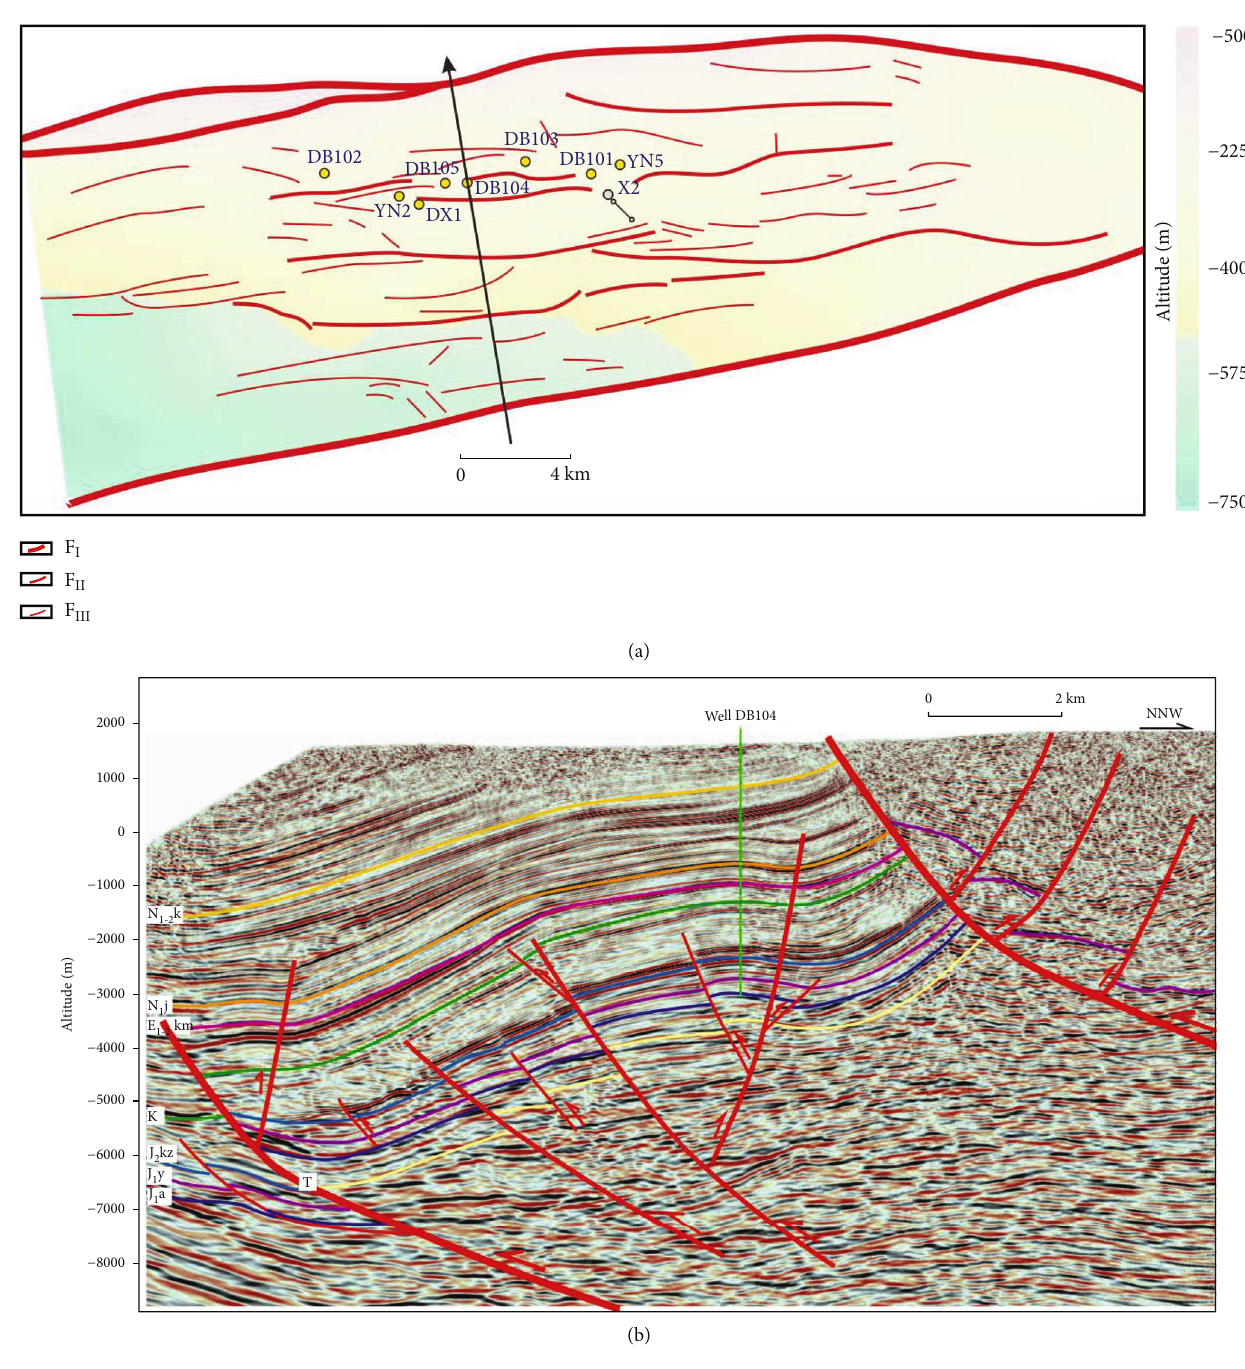
Figure 2: Top structural map and seismic pro fi le of the Jurassic Ahe Formation in the Dibei gas reservoir. (a) There are many faults in the Dibei gas reservoir, which are generally divided into three levels. (b) The Dibei block is characterized by a south-dipping